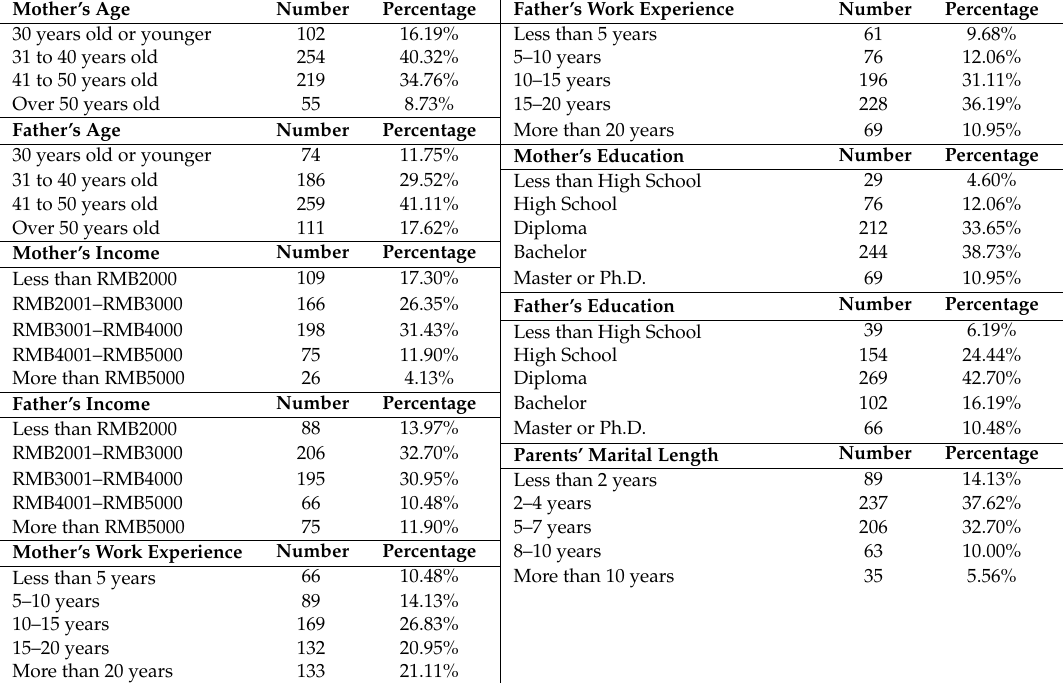
Table 3. Descriptive statistics of family characteristics.